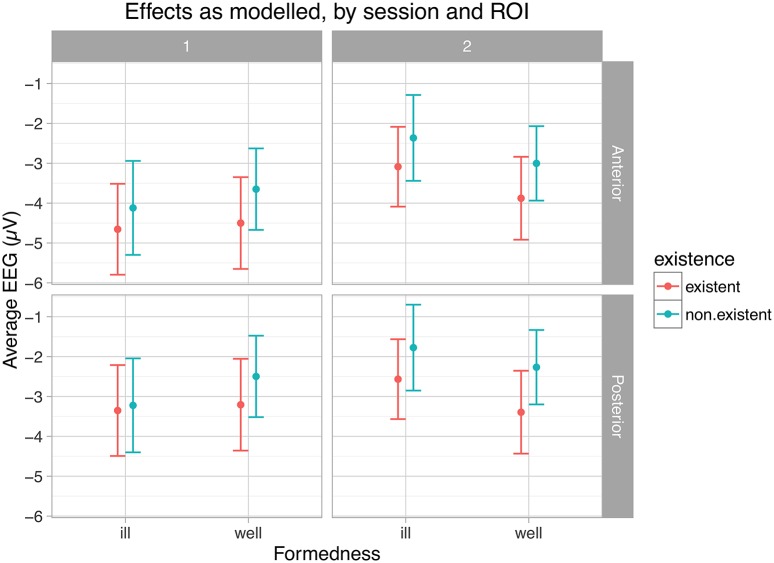
Main effects and interactions for the time window 450–550 ms. EEG-sessions are denoted by 1 and 2, ROIs by Anterior and Posterior.